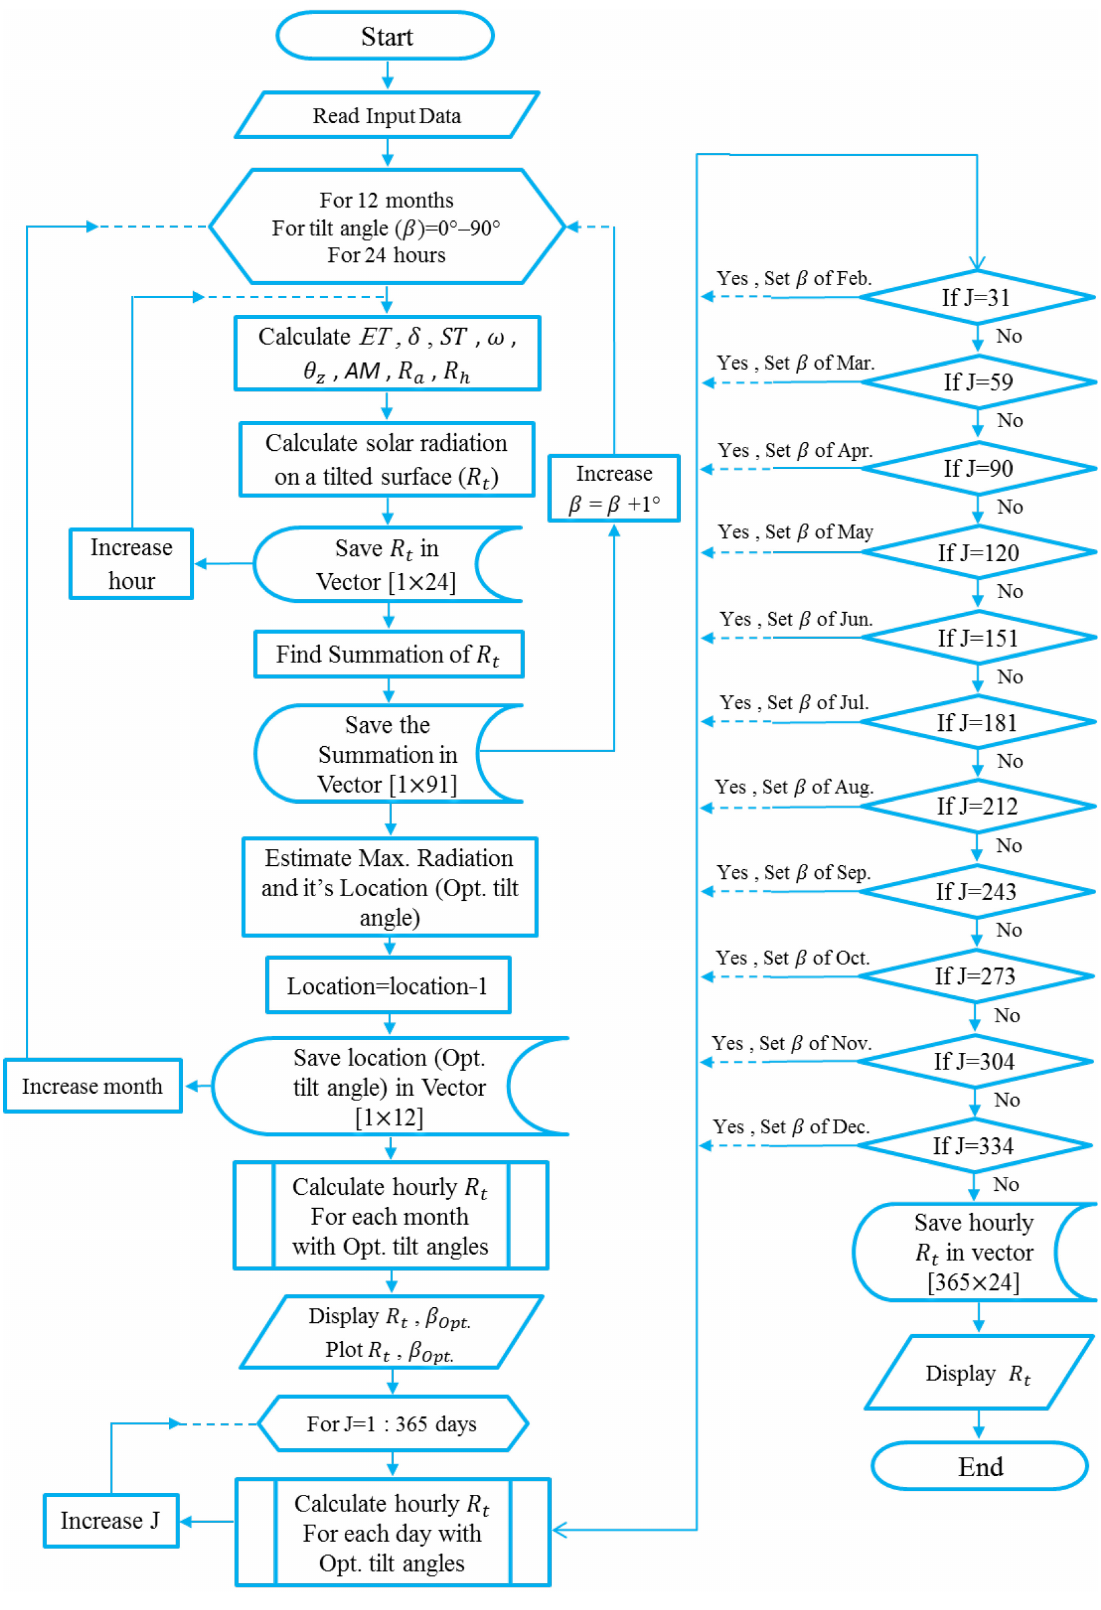
Figure 9. Proposed algorithm for optimization tilt